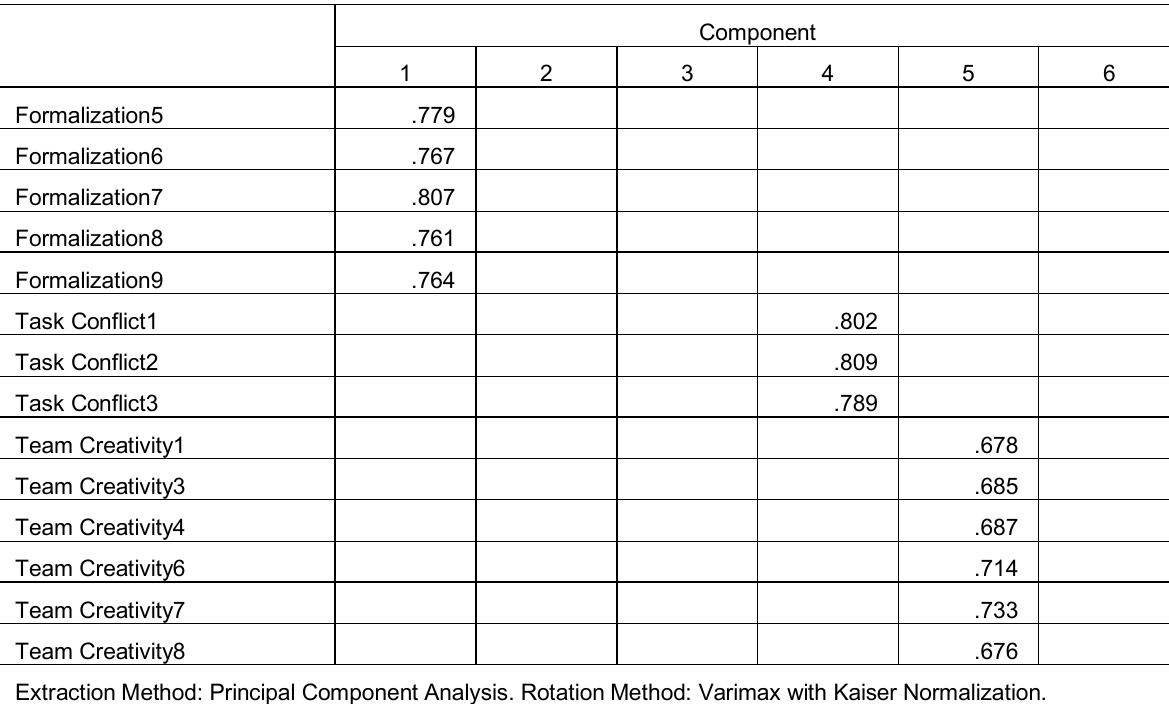
Table 4: Rotated Component Matrix a